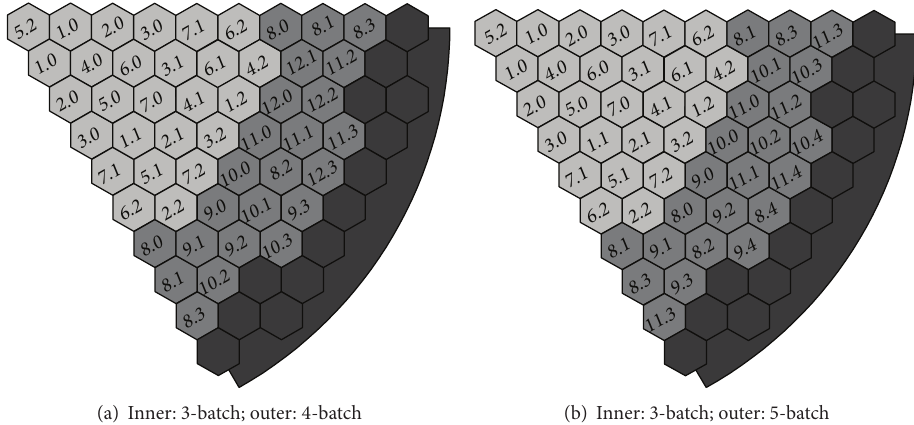
Figure 10: Core loading scheme (m.n: m—the assembly group number; n—cycles of the assembly has been burned).